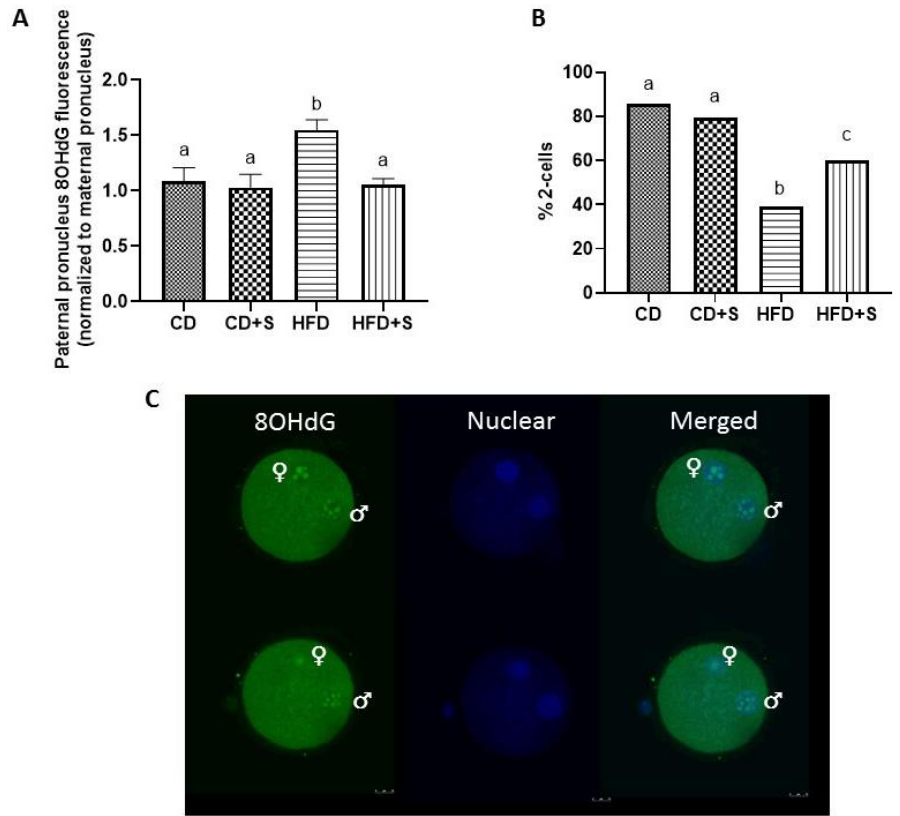
Figure 4. The effect of diet and short-term micronutrient supplementation on oxidative DNA damage (8OHdG) in the male pronucleus and 2-cell cleavage rates. ( A ) Quantified fluorescent intensity of the paternal pronucleus normalized to the maternal pronucleus in the subsequent embryo; ( B ) 2-cell cleavage rates; and ( C ) representative images of 8OHdG fluorescence in the male and female pronucleus of PN3 zygotes. Data are expressed as mean ± SEM. n ≥ 20 pronuclear embryos per diet group. Values are a proportion of total embryos for day 2 cleavage rates, n ≥100 embryos per diet group. CD: control diet, CD + S: control diet plus micronutrient supplementation, HFD: high fat diet, HFD + S: high fat diet plus micronutrient supplementation. 8ohdG in pronuclear embryos was analyzed by a one way ANOVA while 2-cell cleavage rates were analyzed by a binomial generalized linear model with LSD post hoc. Different letters denote significantly distinct groups at p < 0.05.